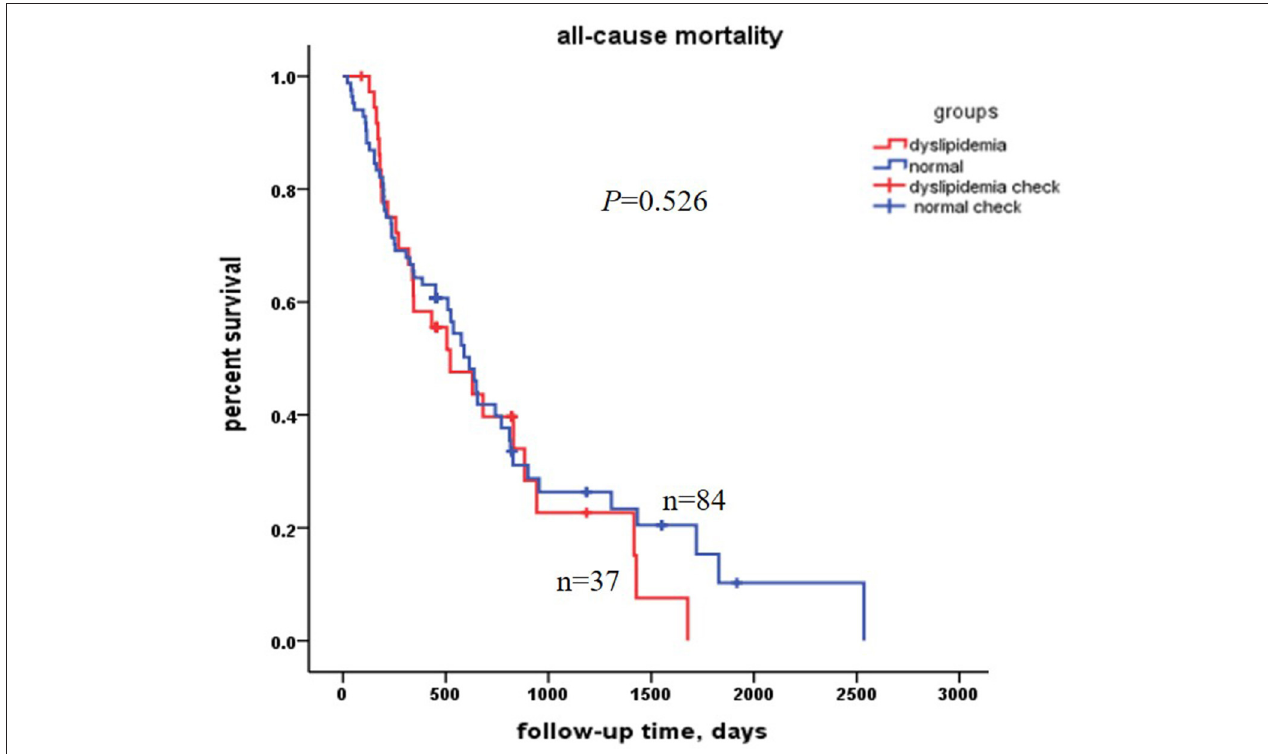
FIGURE 1 | Kaplan–Meier survival curves estimation for all-cause mortality in the 121 centenarians. There was no significant difference between the dyslipidemia centenarians and the normal